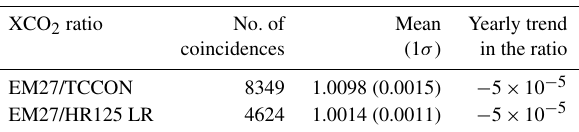
Table 3. XCO 2 biases between the EM27/SUN and HR125 data sets. XCO 2